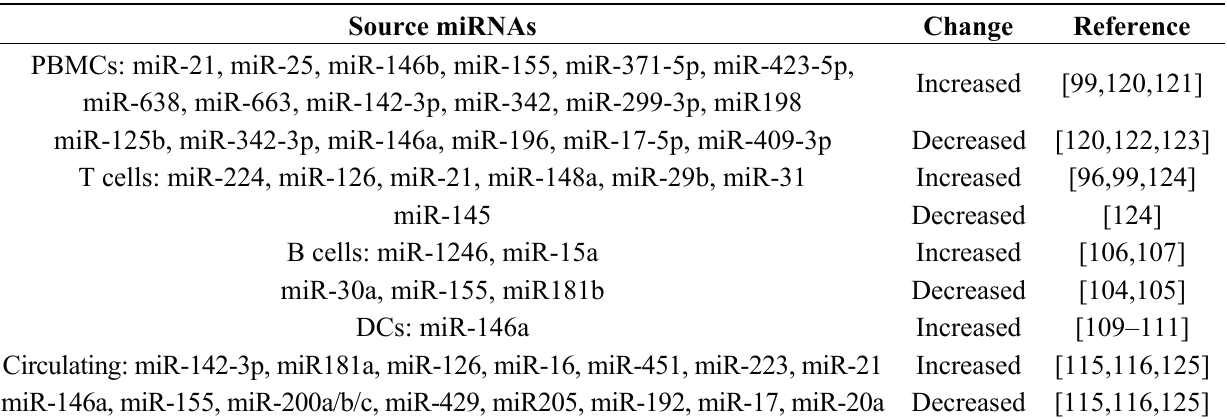
Table 2. Aberrant miRNA expressions in